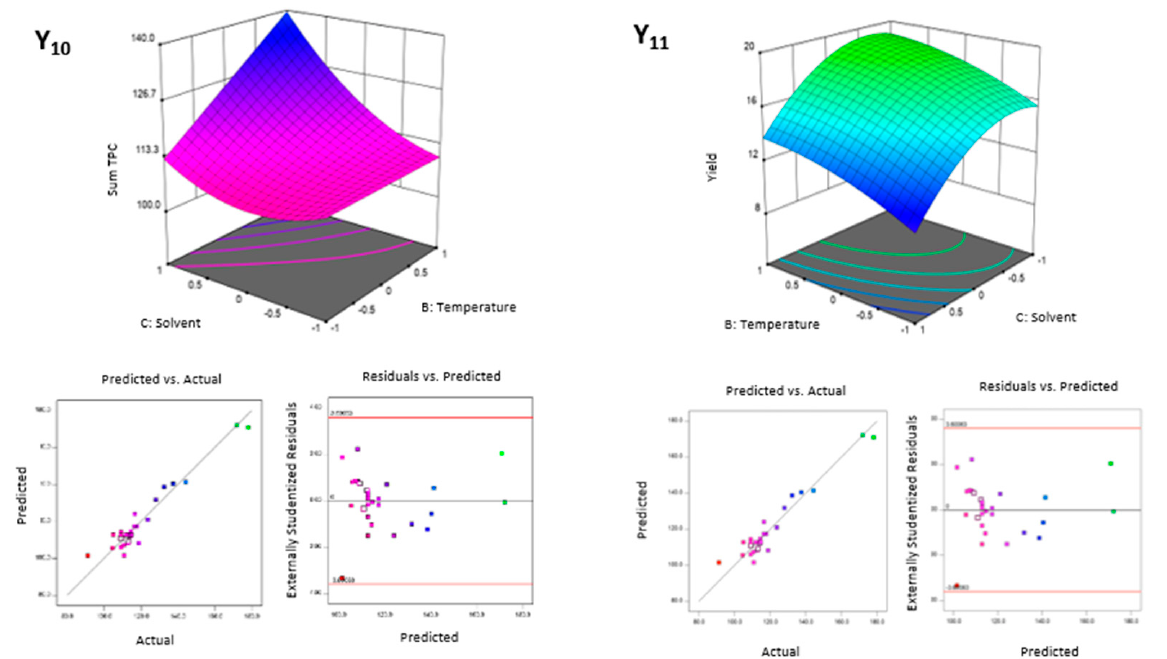
Figure 5. RSM graphs from the responses Y 10 (Total phenolic acids, mg/g Ext) and Y 11 (Yield, %), with statistical diagnostic representations. Each graph displays temperature vs solvent factors, with a time factor adjusted to 0, along with two statistical diagnostics attached. On the left, the graphical representation of the adjustment between predicted vs actual points, and on the right, the graphical representation of residuals vs predicted